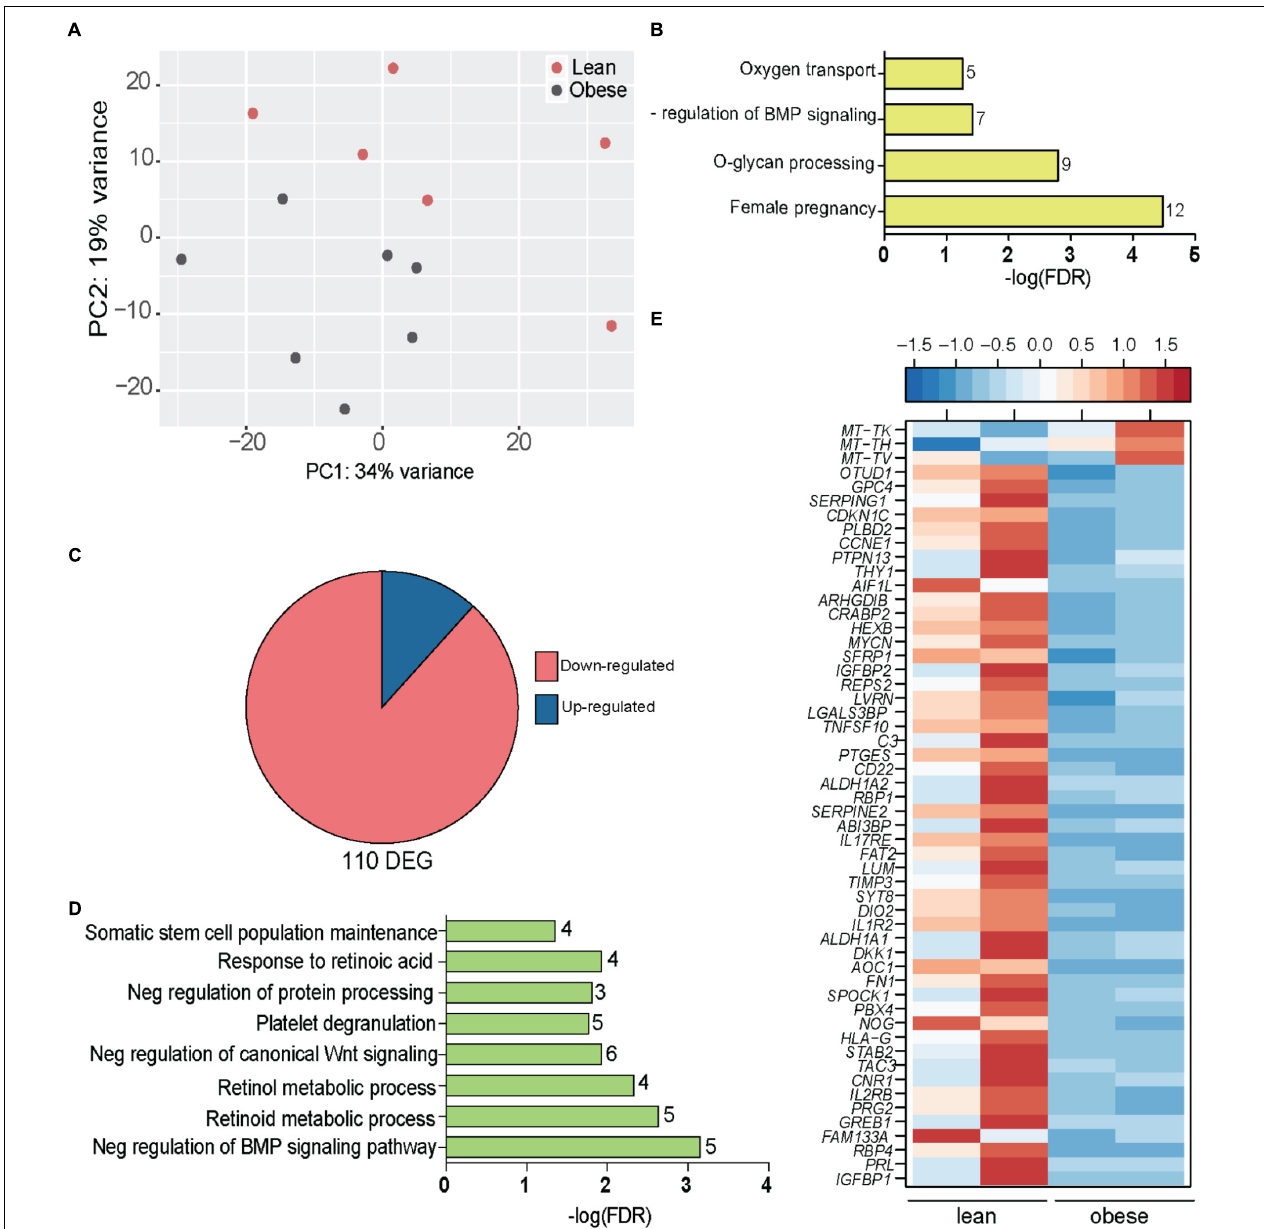
FIGURE 4 | Obesity during pregnancy alters the placental transcriptome. (A) Principal Component Analysis of absolute gene expression of 500 most variable genes. (B) Functional enrichment of the 500 variable genes evaluated using DAVID. Numbers adjacent to the bar represent number of genes mapping to the gene ontology (GO) term. (C) Pie chart denoting number of differentially expressed genes (DEG) identified by edgeR with at least two-fold change in expression and FDR controlled at 5%. (D) Functional enrichment of 110 DEG using DAVID. Numbers adjacent to the bar represent number of DEGs mapping to the GO term (FDR < 5%). (E) Heatmap of genes mapping to disease terms “Immune System Diseases” and “Pregnancy Complications (FDR < 5%) (See Supplementary Figure 4A